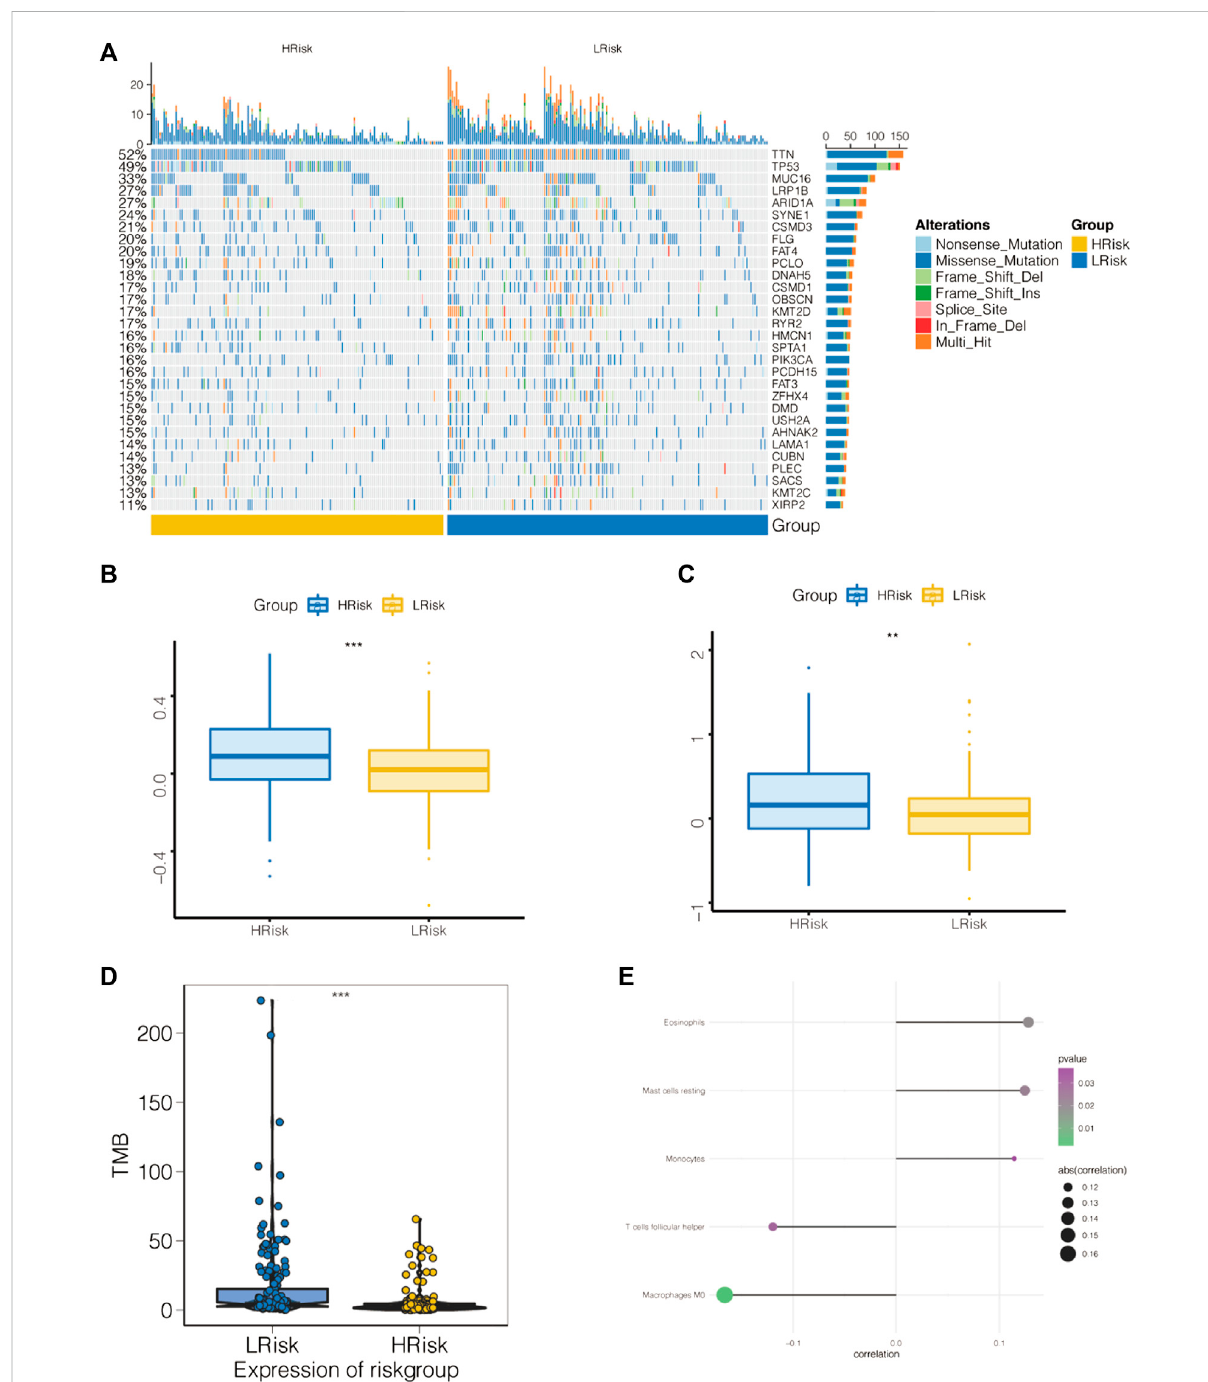
FIGURE 8 Association of apoptosis risk score with immunotherapy response and tumor mutation load. (A) Top 30 mutated tumor genes. (B) Boxplot representation of T cell dysfunction scores in the high-risk group versus low-risk group. (C) Boxplot representation of T cell exclusion scores in the high-riskgroupversuslow-riskgroup. (D) Relationshipbetweenlow-riskscoreandhigh-riskscoretumormutations. (E) Comparisonofimmunecell components of low-risk score and high-risk score patients by CIBERSORT. * p < 0.05, ** p < 0.01, and *** p <